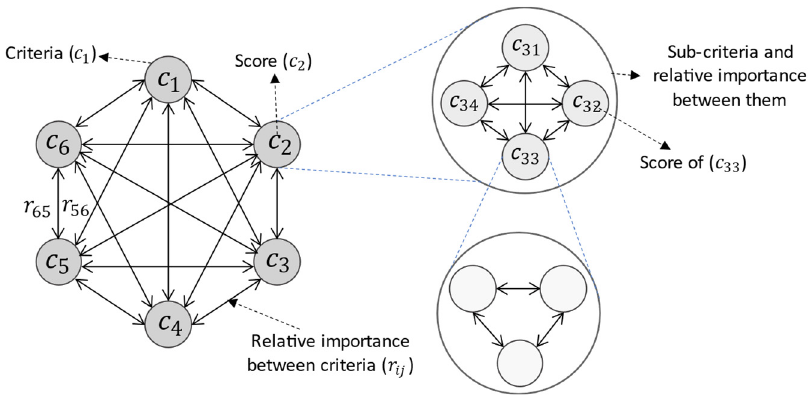
Figure 3. Criteria and sub-criteria framework for GT-MP-DM, adopted from [49].